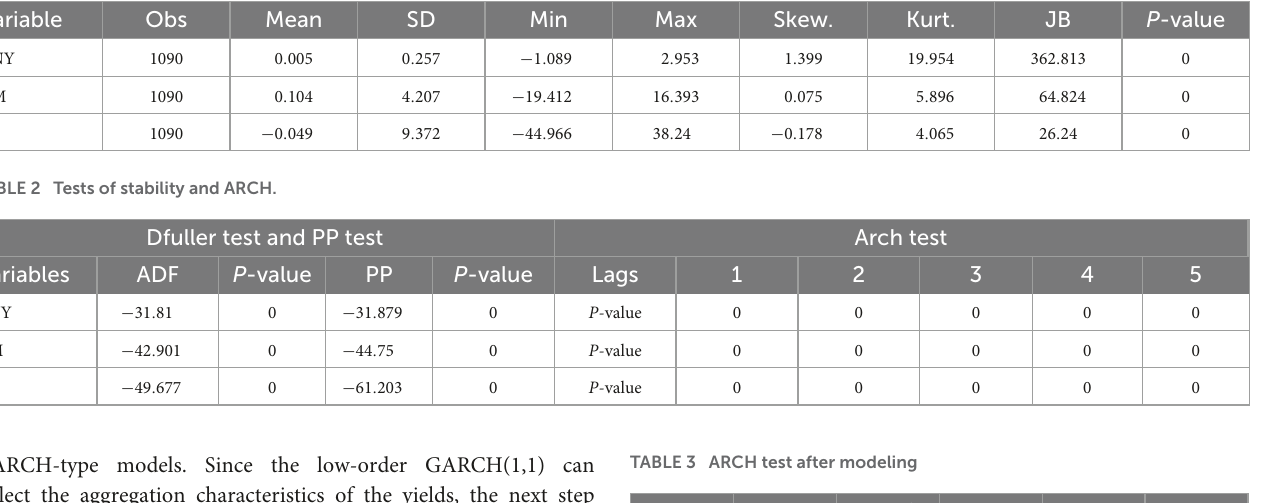
TABLE 1 Descriptive statistics.